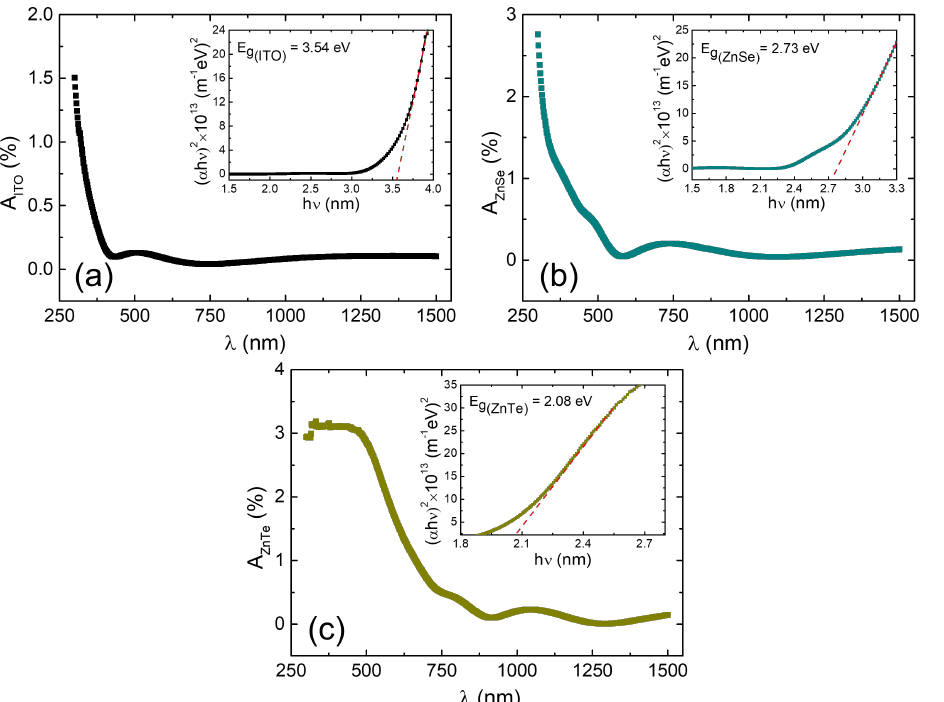
Figure 4. Absorbance spectra of the RF-sputtered ITO ( a ), ZnSe ( b ) and ZnTe ( c ), representing the dependency of the optical absorbance coefficient on the incident photons. The insets represent corresponding linear fit representation (using Tauc’s method) utilized to compute the optical band gap energies of the thin